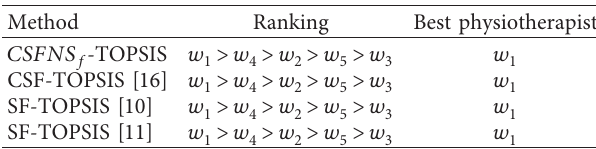
Table 51: Comparison.